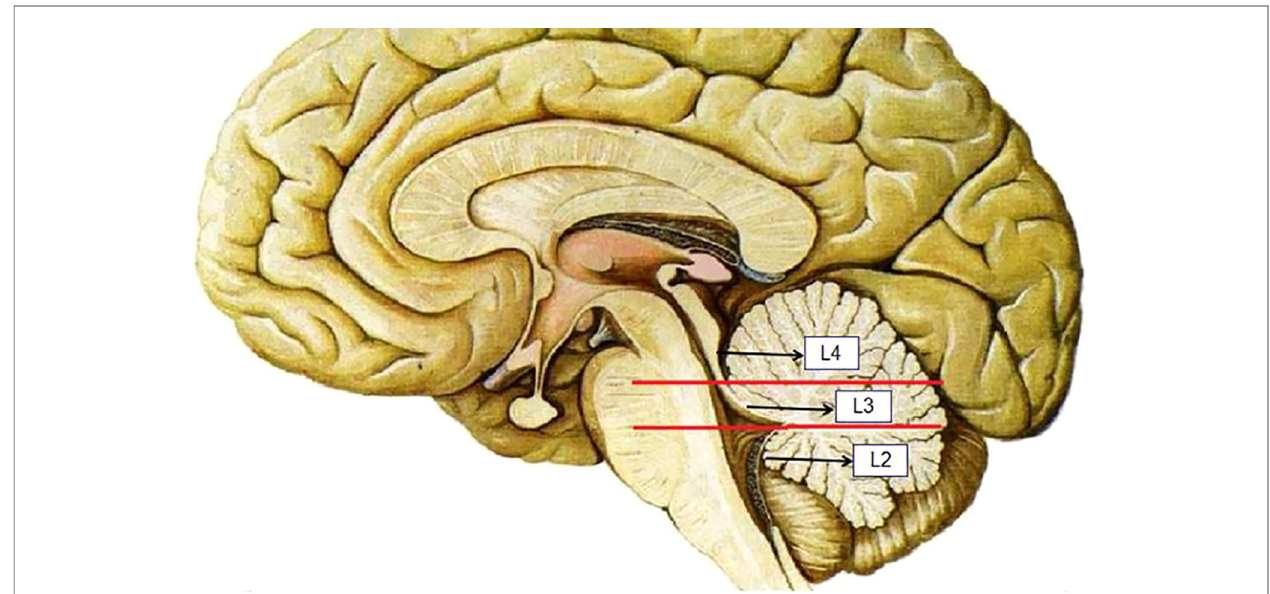
FIGURE 1 | Section of L2, L3, and L4 according to the in fi ltration height of the tumor in the subtentorial ventricular